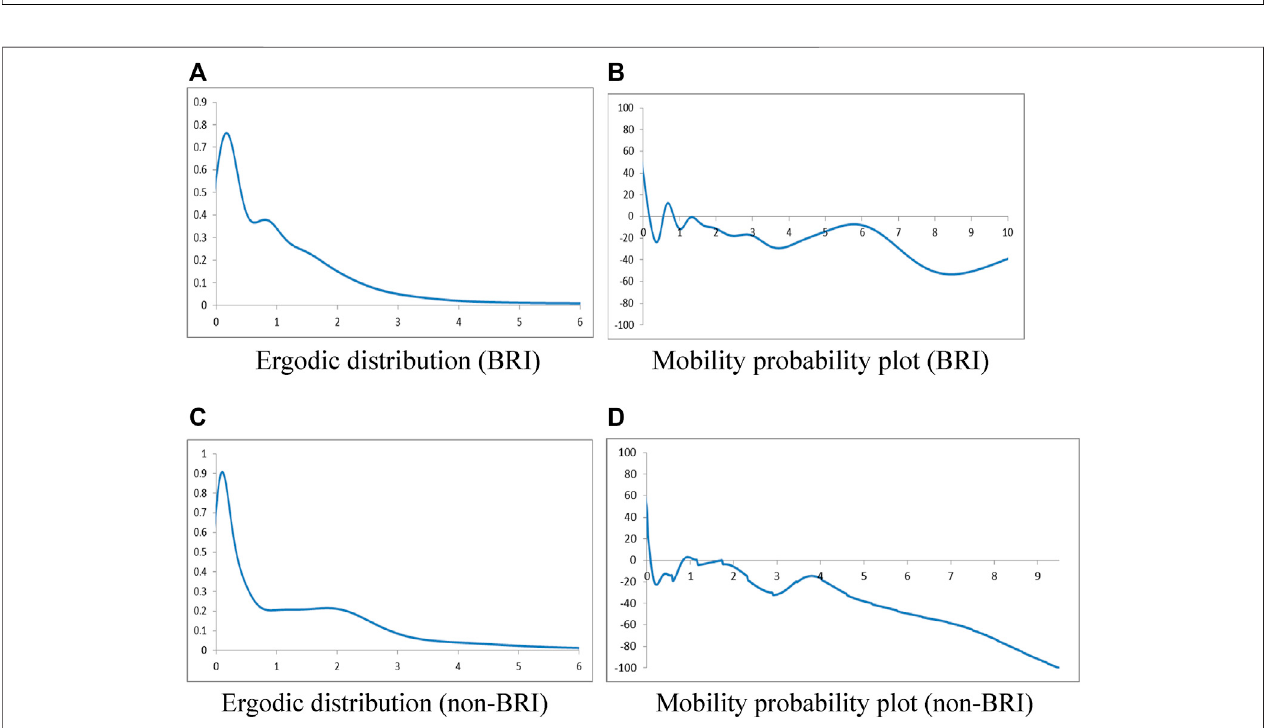
FIGURE 4 | Ergodic distribution and Mobility probability plot of carbon emission per capita. (A) Ergodic distribution (BRI). (B) Mobility probability plot (BRI). (C) Ergodic distribution (non-BRI). (D) Mobility probability plot (non-BRI).